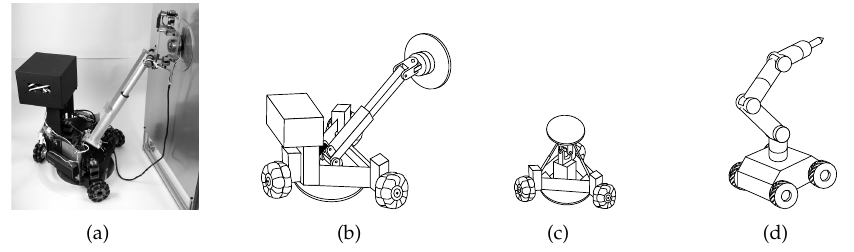
Figure 11. Mobile robots used in examples. ( a ) Pusher robot. ( b ) Schematic of a pusher robot. ( c ) Schematic of a transporter robot. ( d ) Mobile robot with a six-axis manipulator.